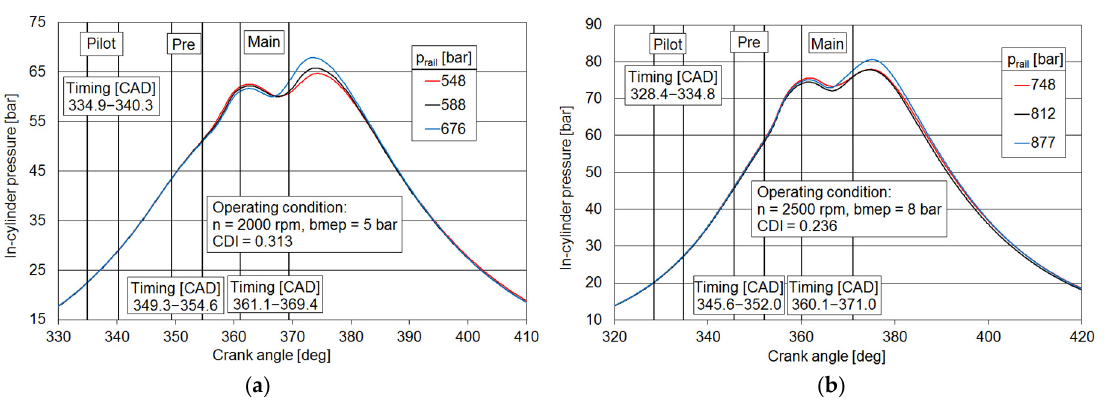
Figure 5. Influence of rail pressure control on pressure diagrams in operating condition No.2 ( a ) and No.3 ( b ).